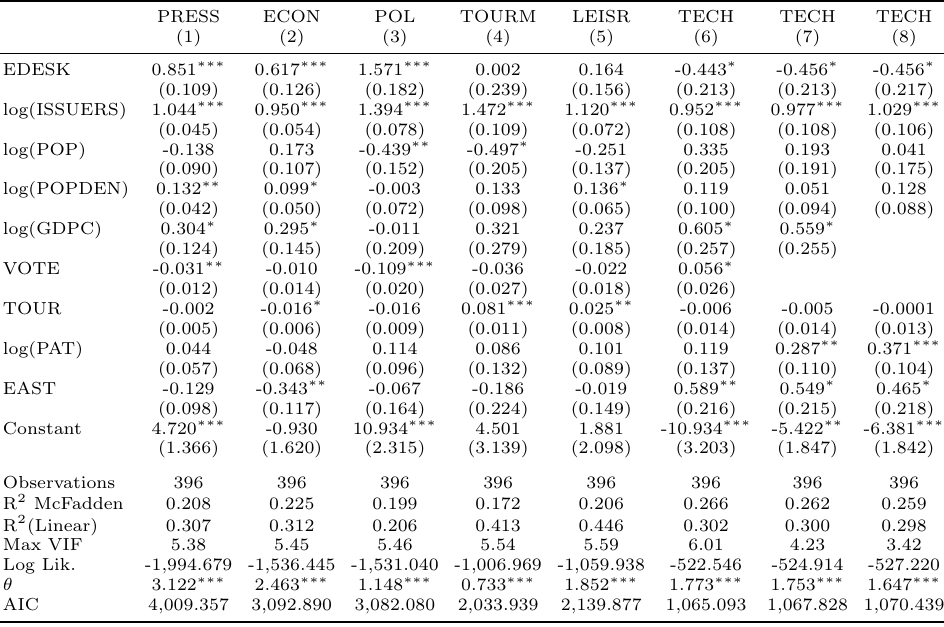
Table 3: Determinants of visibility in press